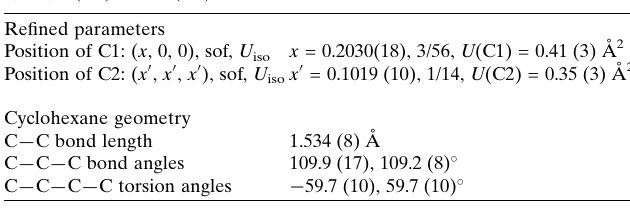
Table 2 Refined structure of plastic cyclohexane at 255 K. Refined parameters are x , x 0 , U (C1) and U (C2).